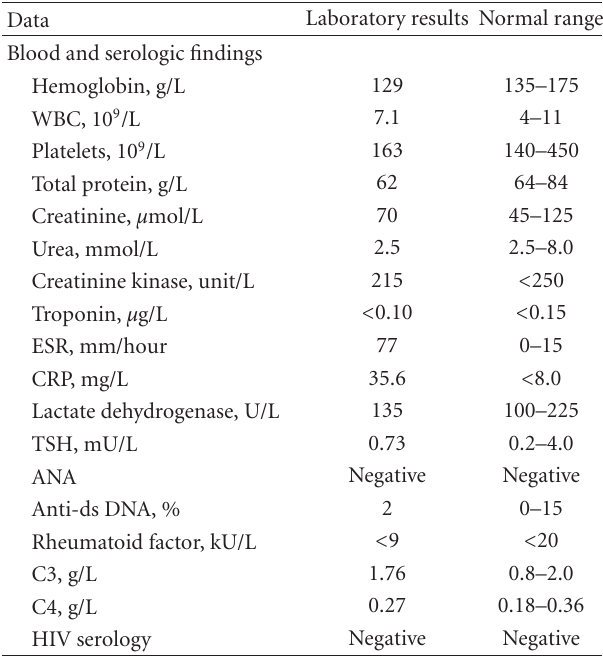
Table 1: Relevant blood and serologic findings.